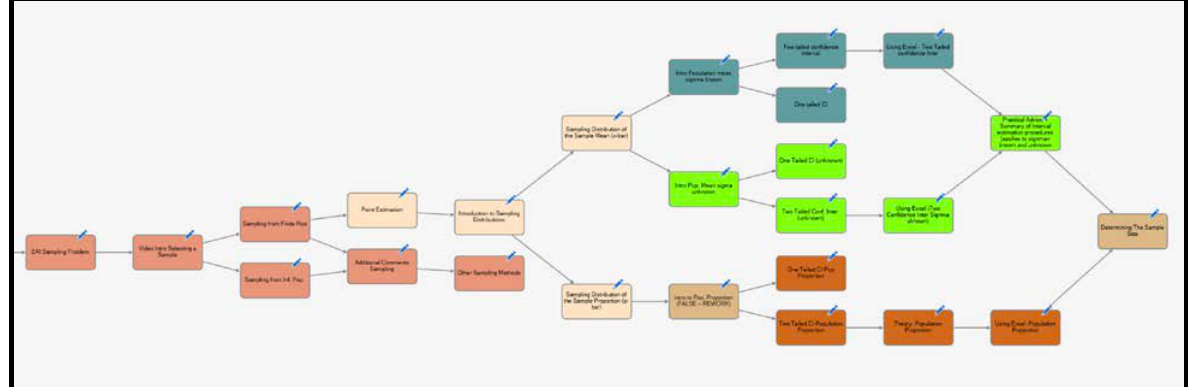
Figure 5a. A portion of a Realizeit learning path in QMB3200 (modules 2 and 3). Adapted from QMB3200: Quantitative Business Tools II , by T. Buhagiar, 2018, Orlando, FL: University of Central Florida. Copyright 2019 from the University of Central